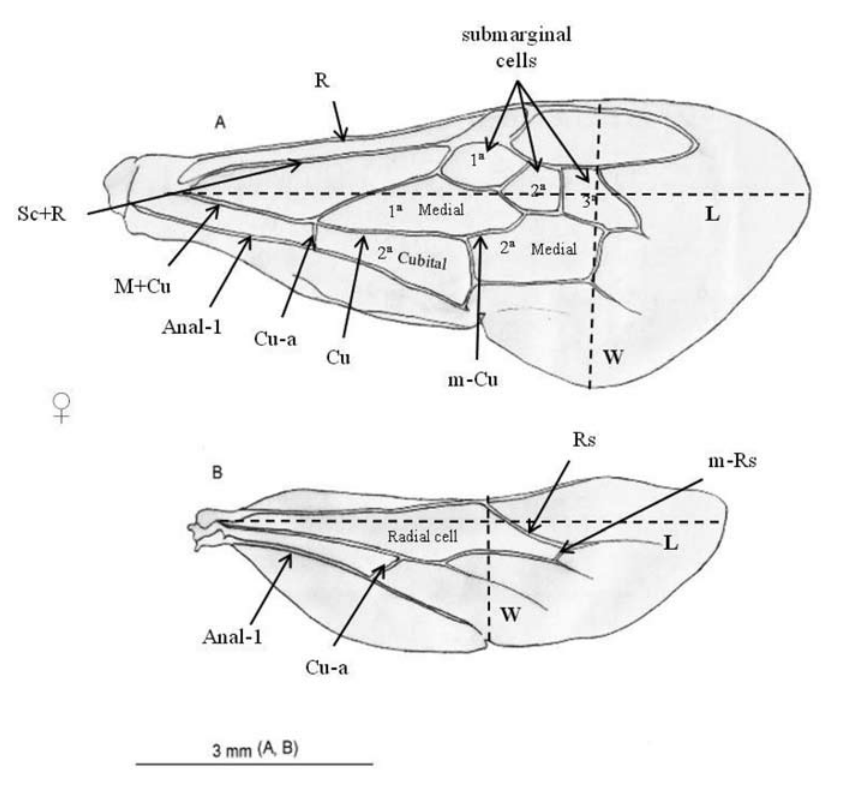
Fig. 2 – Linear measurements of morphological characters of the forewing (A) and hindwing (B) female Tetrapedia diversipes by conventional morphometric. Legend: Length (L), width (W), Radial + Subcostal veins (Sc + R), Cubital vein (Cu), Cubital-anal (Cu-a), Middle-Cubital or median-Cubital (m-Cu), Radial (R), Radial sector (Rs), median-Radial sector